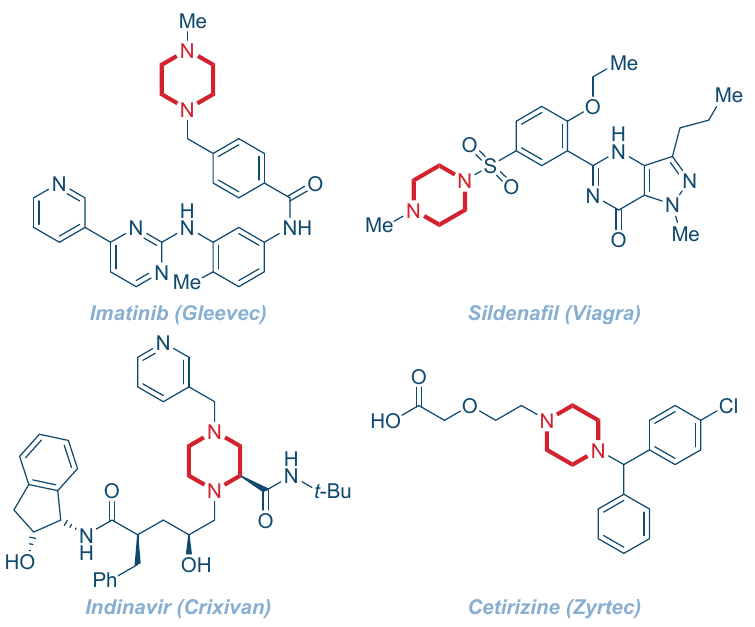
Figure 1. Blockbuster drugs that incorporate the piperazine ring.